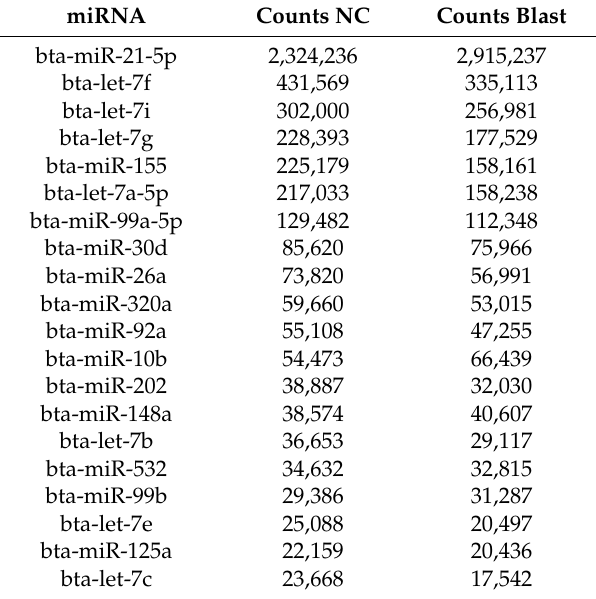
Table 2. Most abundantly-expressed microRNAs (miRNA).